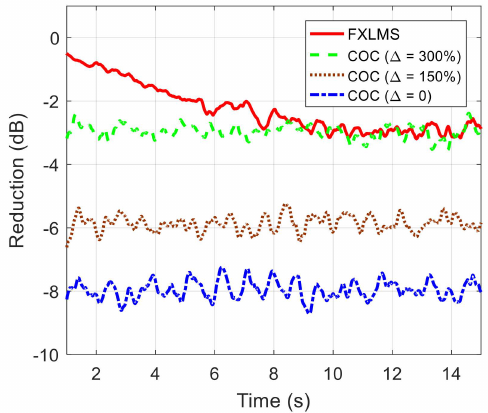
Figure 8. Control results with di ff erent uncertainties.